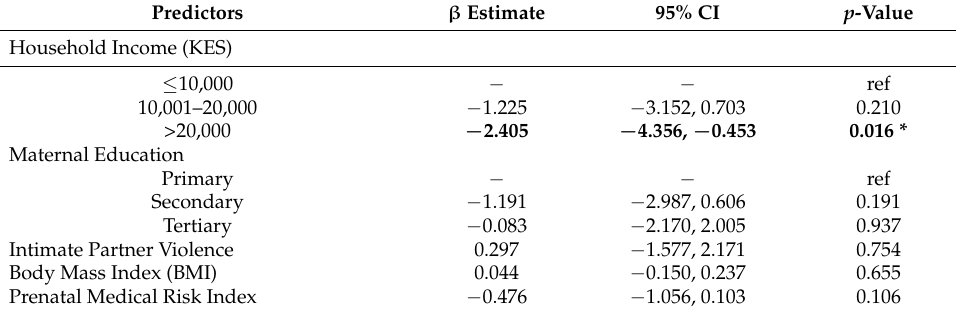
Table A6. Results of multivariate regression analysis for PSS scores.